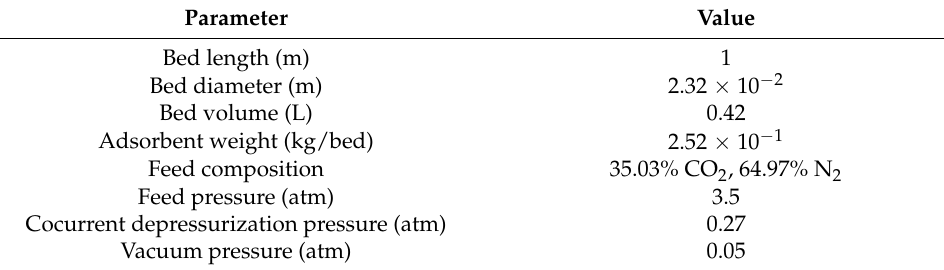
Table 3. Operation conditions for the single-bed three-step PSA process.